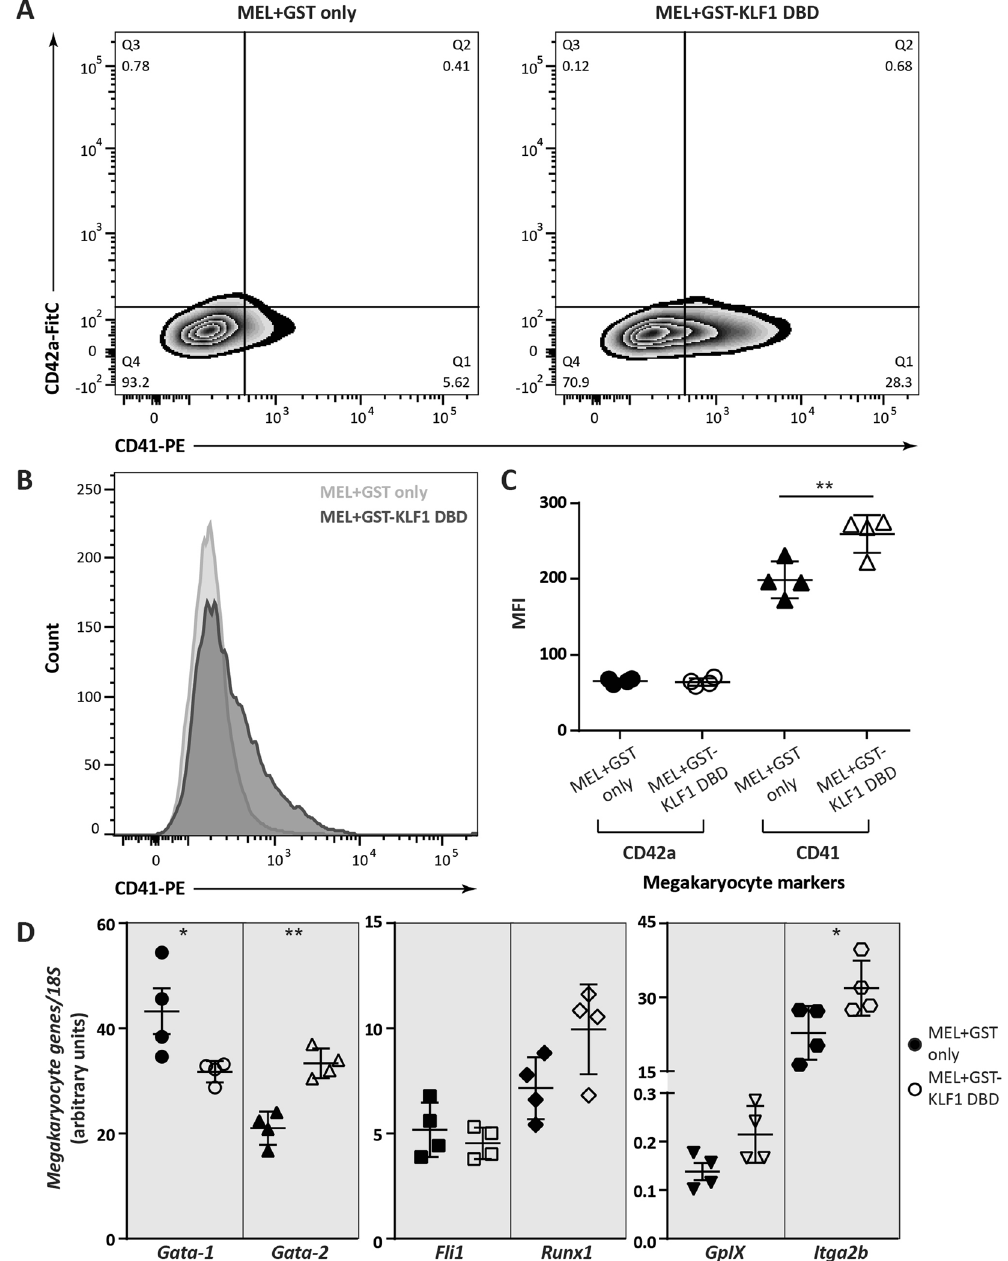
Figure 3. MEL cells overexpressing GST-KLF1 DBD display a more pronounced megakaryocyte phenotype. ( A ) Representative flow cytometry plots of MEL + GST and MEL + GST-KLF1 DBD cells stained with antibodies against CD42a and CD41. ( B ) Histogram of flow cytometry for CD41 in a representative GST and GST-KLF1 DBD clone. ( C ) Statistical analysis of flow cytometry data for erythrocyte markers from all clones. ( D ) Absolute levels of megakaryocyte related gene expression were analysed by real time qPCR in un-induced GST expressing clones compared to GST-KLF1 DBD expressing clones. Expression levels were normalised to 18S rRNA. n = 4 for each construct. Error bars shown represent standard error of the mean, p values indicate the difference between the means, * p < 0.05, ** p < 0.01 (paired Student’s two-tailed t